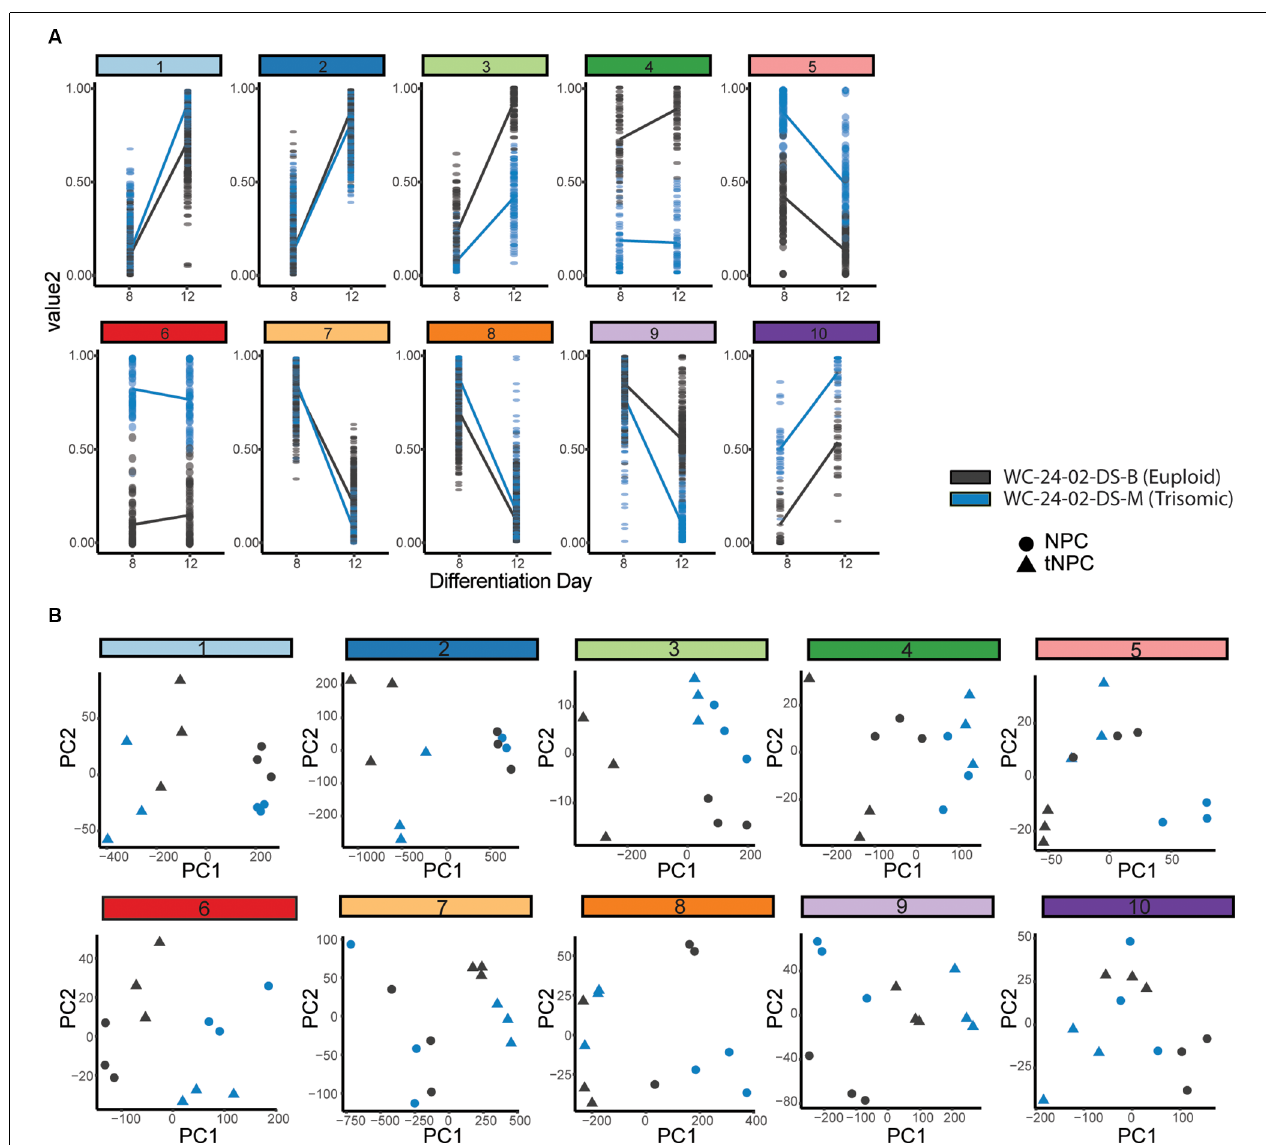
FIGURE 5 | Hierarchal clustering and PCA identify gene clusters driving differentiation. (A) Hierarchal clustering of the 1,000 DEX genes expressed during the transition of the euploid (WC eu ) and trisomic (WC ts ) cells from NPCs to tNPCs identifies 10 different patterns of gene expression. (B) Principal component analysis identifies whether the primary driver of the expression pattern in each cluster is due to differentiation day or genotype by correlating PC1 with either differentiation